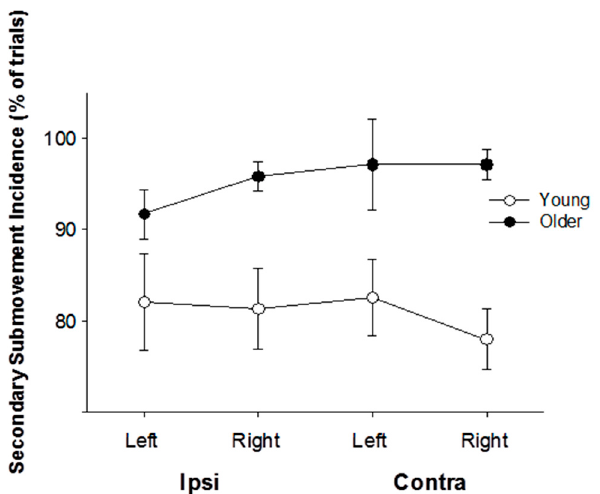
Figure 3. Older adults produce secondary submovements more often than young adults. This figure shows the percentage of trials in which the target was not achieved with the primary submovement and required a secondary submovement. In all conditions, young participants needed a secondary submovement in fewer trials compared with the older group ( p < 0.01).